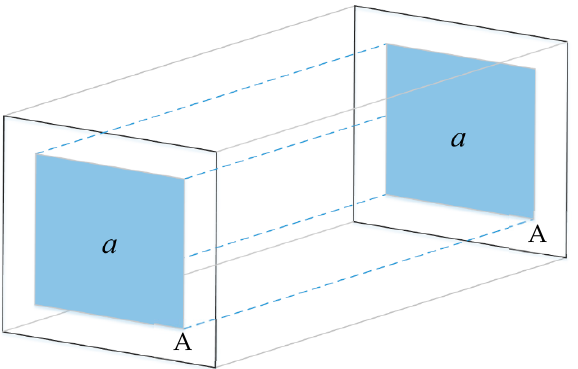
Figure 8. IELoss calculation area diagram. Blue region a is the loss value calculation area of the IEU-Net model. White region A is the loss value calculation area of a traditional U-Net model.